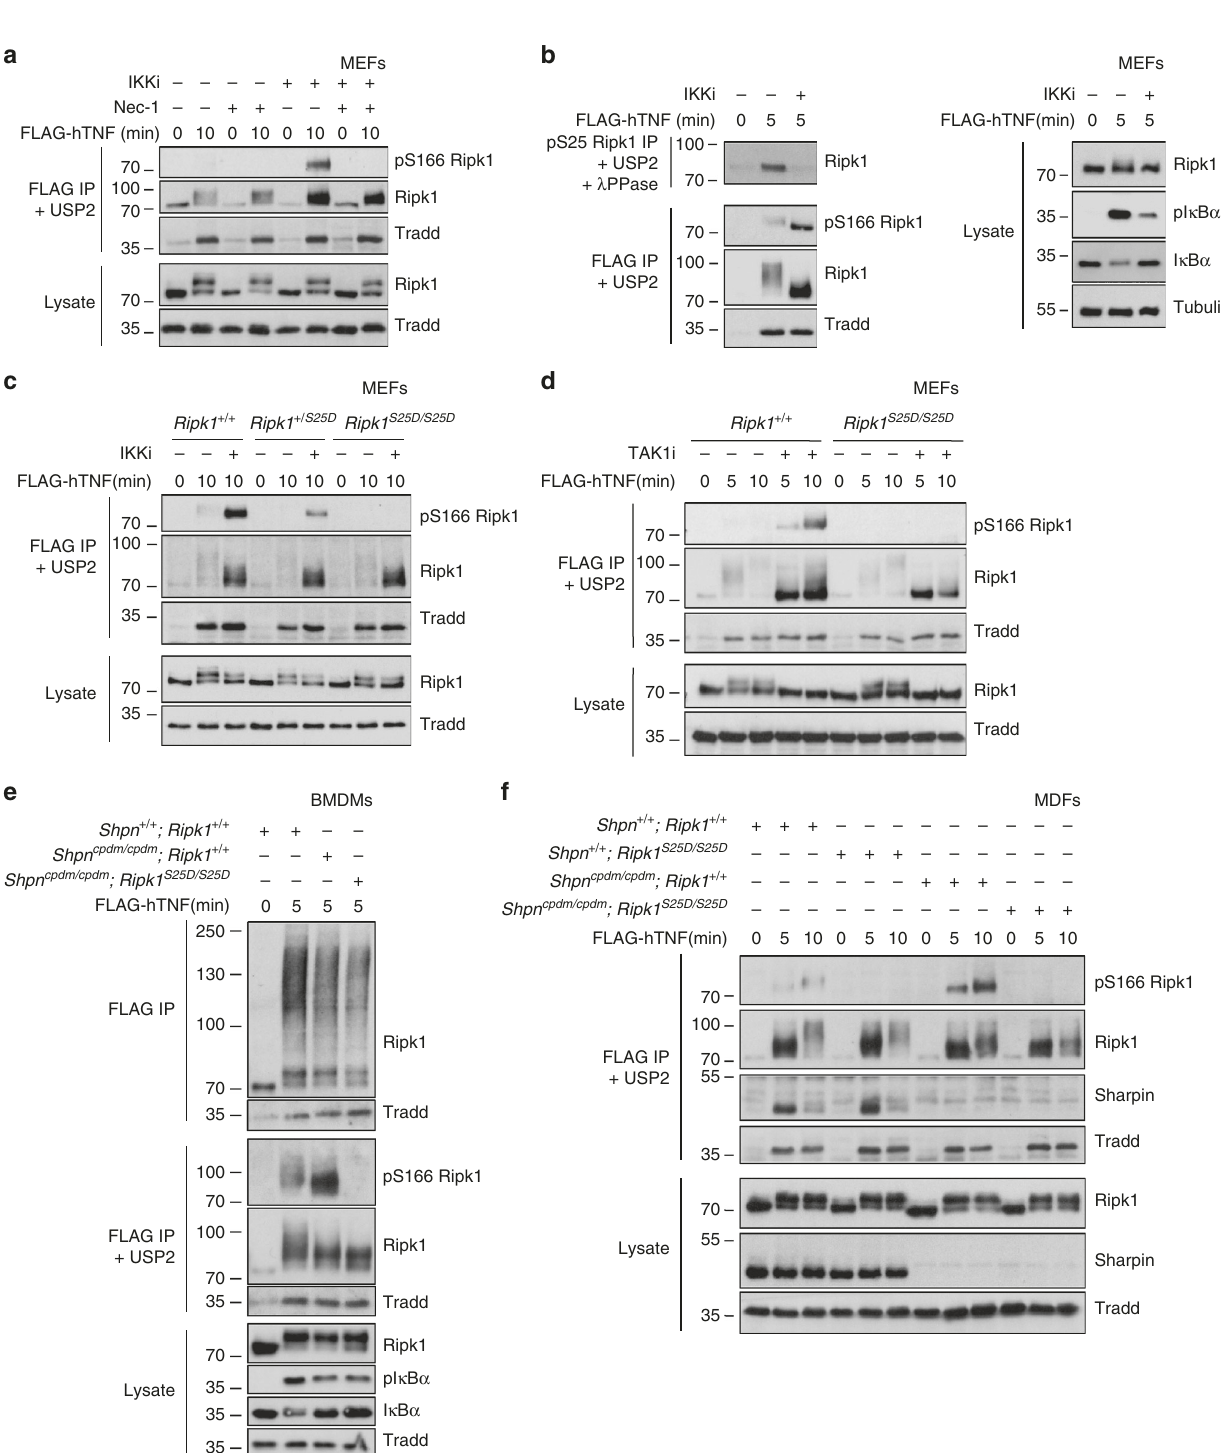
Fig. 5 Phospho-Ser25 prevents RIPK1 kinase activation in complex I. MEFs ( a – d ), BMDMs ( e ) or MDFs ( f ) of the indicated genotypes were pretreated for 30 min with the indicated compounds before stimulation with 1 µ g/ml FLAG-hTNF for the indicated duration. ( a , c – f ) TNFR1 complex I was then FLAG-immunoprecipitated and the IPs were then treated with USP2 when indicated. b The lysates were then split in two to isolate in parallel TNFR1 complex I by FLAG immunoprecipitation and pS25 RIPK1. The IPs were respectively subsequently treated with USP2 and USP2 + PPase. Protein levels were determined by immunoblot. Immunoblots are representative of two ( a – f ) independent Mice . Generation of the Ripk1 S25D knockin mouse line by CRISPR/Cas9 was eggs for KI mouse production. F1 heterozygous breeding pairs were obtained from Cyagen and used for establishment of the Ripk1 S25D colony. Shpn cpdm mice were outsourced to Cyagen (USA). The AGC serine-encoding codon in exon 2 of the mouse RIPK1 locus was altered to a GAT codon encoding for glutamate. To do so, kindly provided by Prof. H. Walczak and were described earlier 44 . Crosses between Cas9 mRNA, gRNA (5 ’ -gacctagacagcggaggcttcgg-3 ’ ) generated by in vitro tran- the Shpn cpdm and Ripk1 S25D were validated by genotyping. All in vivo experiments scription and oligo donor (with targeting sequence, fl anked by 120 bp homologous were performed with littermate mice. Primary cultures were isolated from litter- sequences combined on both sides) were co-injected into fertilized C57BL/6 mouse mate mice. All experiments on mice were conducted according to institutional,